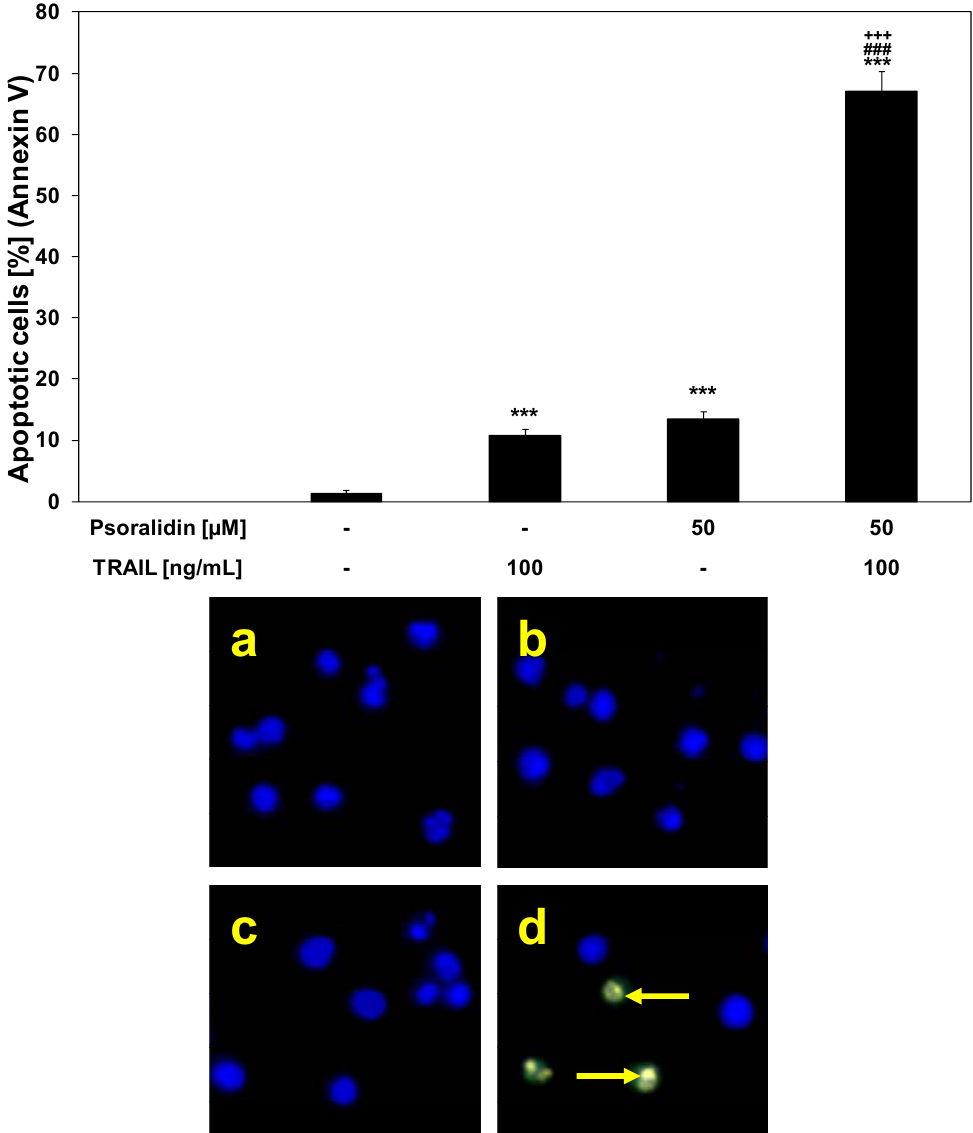
Figure 5. TRAIL induced apoptosis in combination with psoralidin in HeLa cancer cells. The cancer cells were incubated for 48 h with TRAIL at the concentrations of 100 ng/mL and psoralidin at the concentration of 50 μ M. Detection of apoptotic cell deaths by fluorescence microscopic using annexin V-FITC, Ethidium Homodimer III and Hoechst 33342 staining: ( a ) control cells, ( b ) cells incubated with TRAIL, ( c ) cells incubated with psoralidin, ( d ) cells incubated with TRAIL and psoralidin. The values represent mean ± SD of three independent experiments performed in quadruplicate (n = 3) ( *** p < 0.001 compared with control, ### p < 0.001 compared with psoralidin and +++ p < 0.001 compared with TRAIL). The healthy cells (stained with Hoechst 33342) emitted blue fluorescence and apoptotic cells (stained with Annexin V-FITC and Hoechst 33342) emitted green and blue fluorescence. Cells undergoing apoptosis showed nuclei shrinkage, chromatin condensation and nuclei fragmentation, indicated by